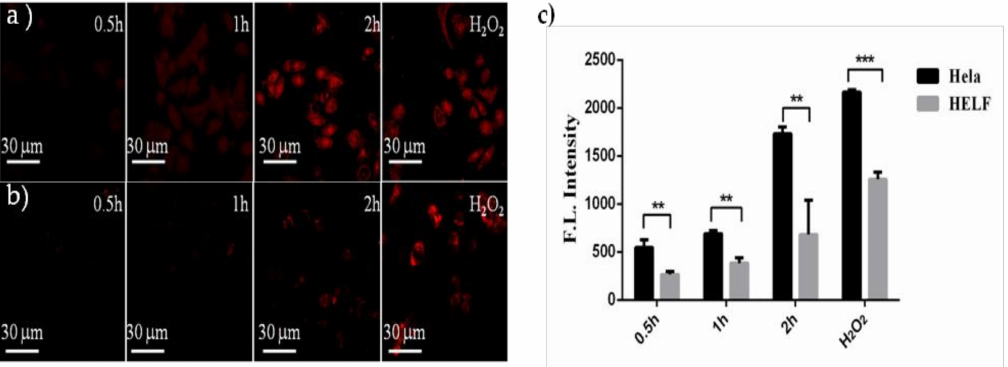
Figure 9. CLSM images of ( a ) HeLa cells and ( b ) HELF cells after incubation with compound 7 (5 µ M) for 0.5 h, 1 h, and 2 h respectively, or cells after incubation with H 2 O 2 (50 µ M) for 0.5 h, followed by treatment of the compound 7 (5 µ M) for another 0.5 h; ( c ) quantitative results of ( a ) and ( b ) (** p < 0.01, *** p <